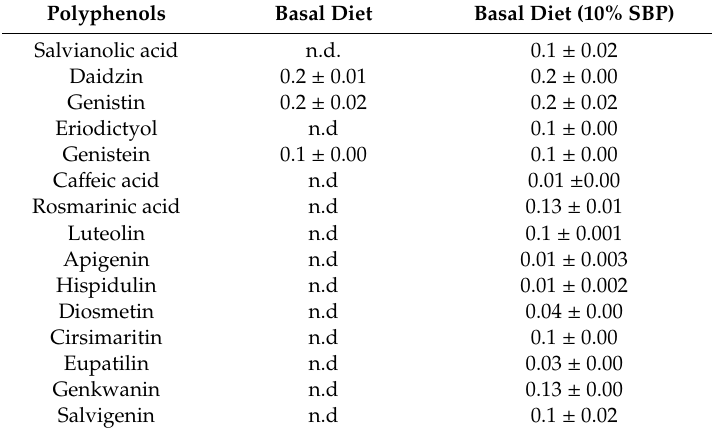
Table 5. Dietary administration of polyphenols present in the concentrate-based diet and in the sage pellets (50% barley-50% distilled Salvia lavandulifolia leaves), (mg /